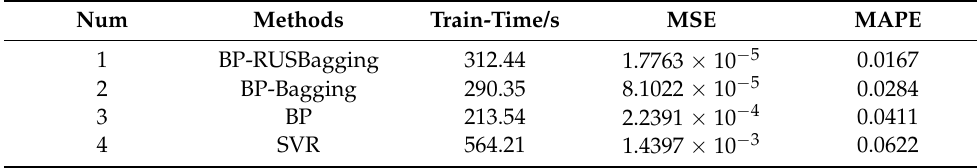
Table 3. Comparison of the performance of different methods on the minority test set.